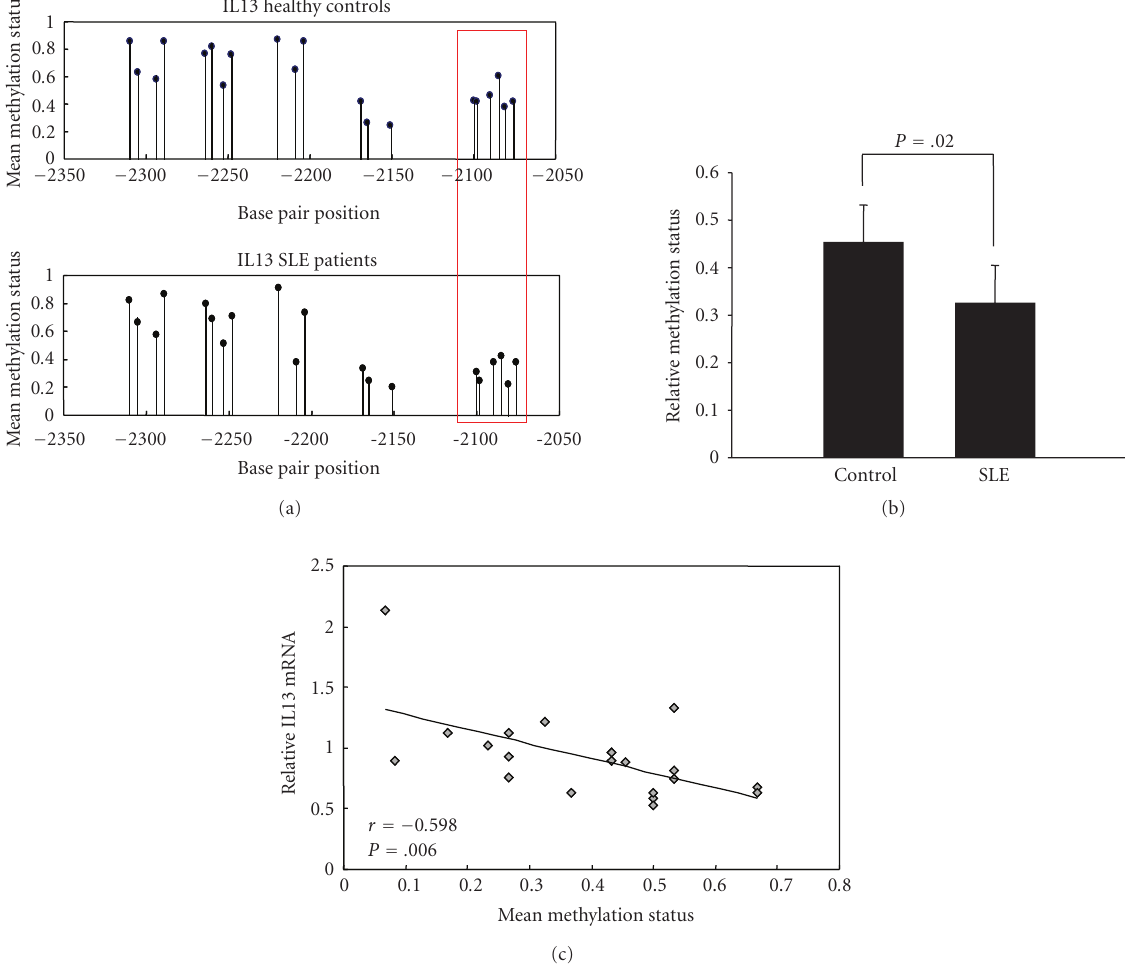
Figure 4: IL13 promoter methylation patterns in CD4 + T cells from SLE patients and healthy controls. (a) The mean methylation status for each of the 20 CG pairs within the distal promoter of the IL13 locus in CD4 + T cells from healthy controls ( n = 10; upper panel) and SLE patients ( n = 10; lower). The boxed area indicates the region (positions − 2100, − 2098, − 2090, − 2085, − 2081, and − 2076) with reduced methylation in SLE patients. (b) The combined average methylation status of the 6 hypomethylated CG pairs in the distal promoter of IL13 in SLE CD4 + T cells was reduced compared with the combined average methylation status of these positions in healthy controls ( P = . 020). (c) Average IL13 promoter (position − 2100 to − 2076) DNA methylation status correlated ( r = − 0 . 598) with relative mRNA level in SLE patients ( P = .